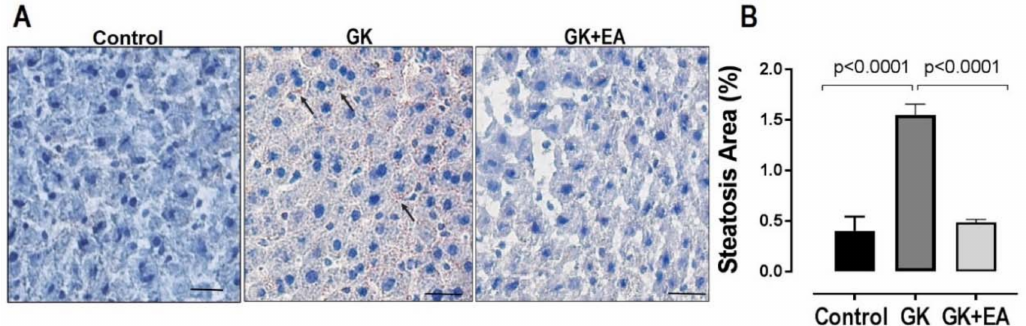
Figure 3. EA treatment reduces hepatic steatosis in diabetic GK Rats. Oil Red staining for detection of fat droplets was preformed in frozen sections of livers from age matched Wistar control, and diabetic GK rats with or without EA treatment (50 mg/kg) for 45 days. ( A ) Representative oil red staining showing steatosis (black arrows). Scale bar: 50 µ m; ( B ) Morpho-quantitative analysis of hepatic steatosis area. Data are represented as mean ± SEM; * p < 0.05, ( n = 6 per